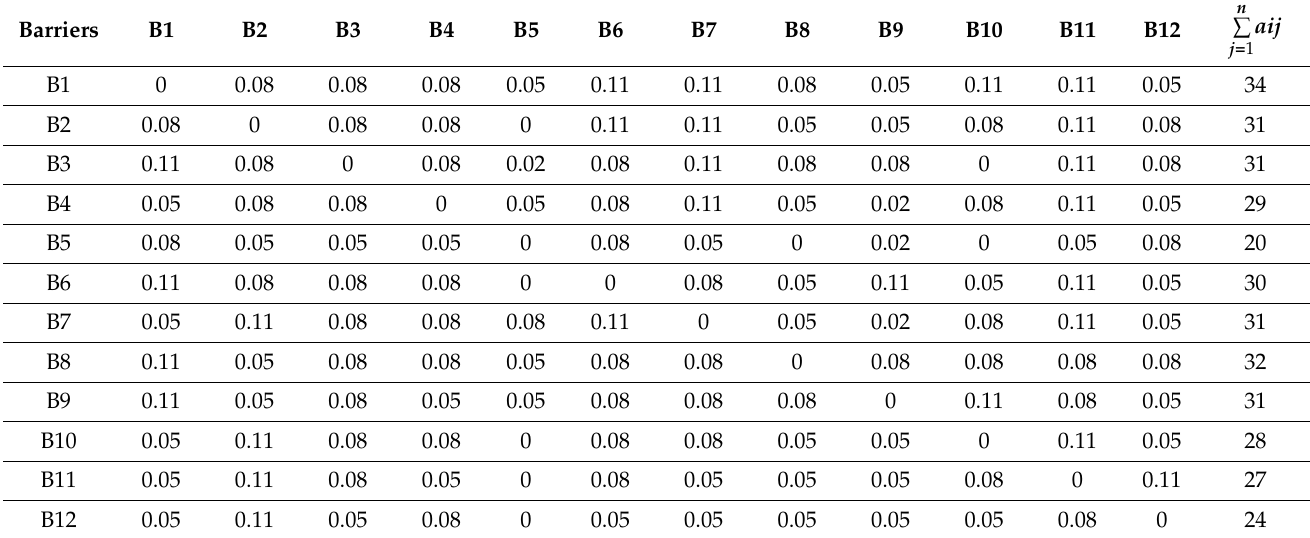
Table 6. Normalizing the direct-relation matrix (X).